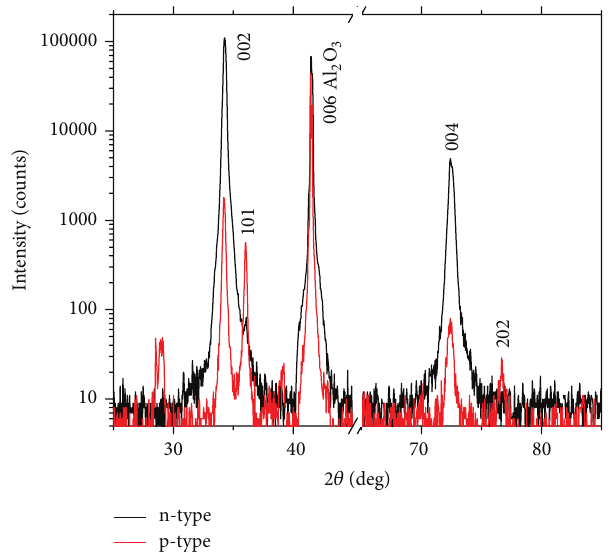
Figure 8: Comparison of X-ray spectra for nominally undoped (black) and N-doped (red) ZnO films grown using an alternating growth